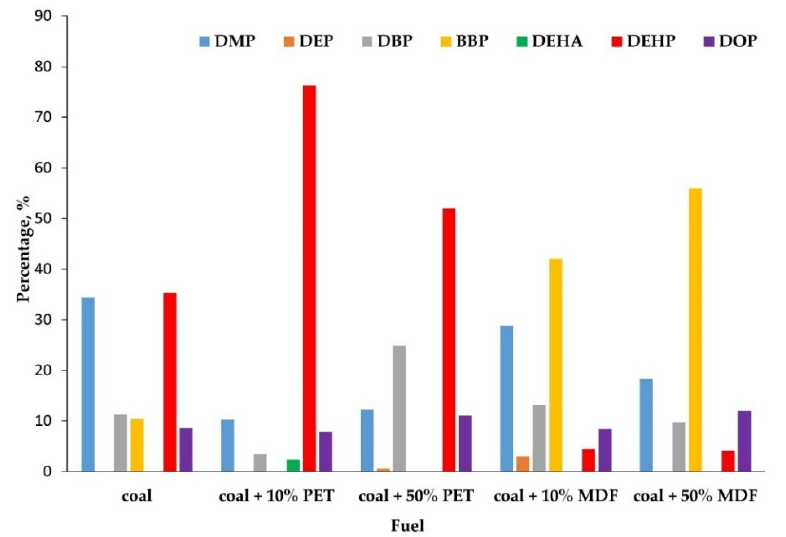
Figure 5. Percentage of individual phthalates in total emission of phthalates.